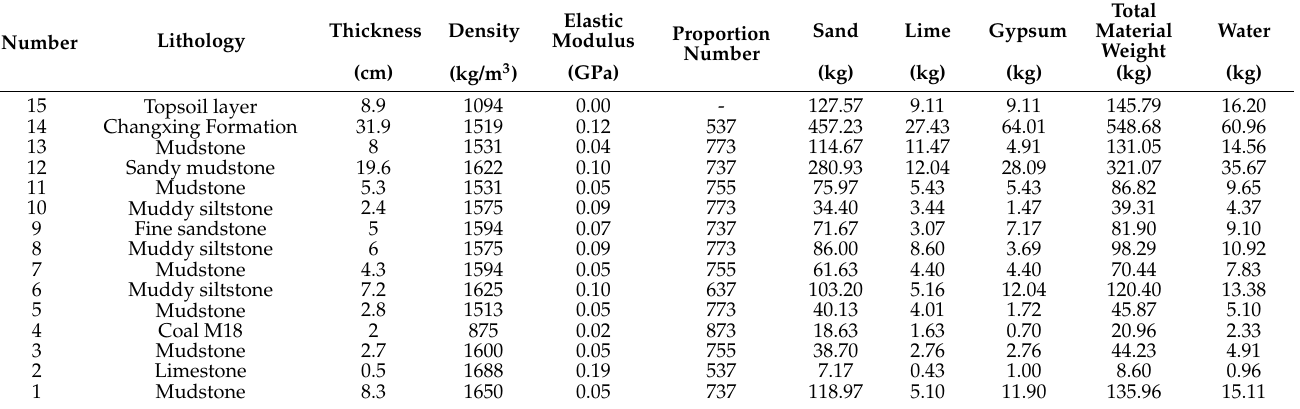
Table 2. Proportion and dosage of similar materials in each rock